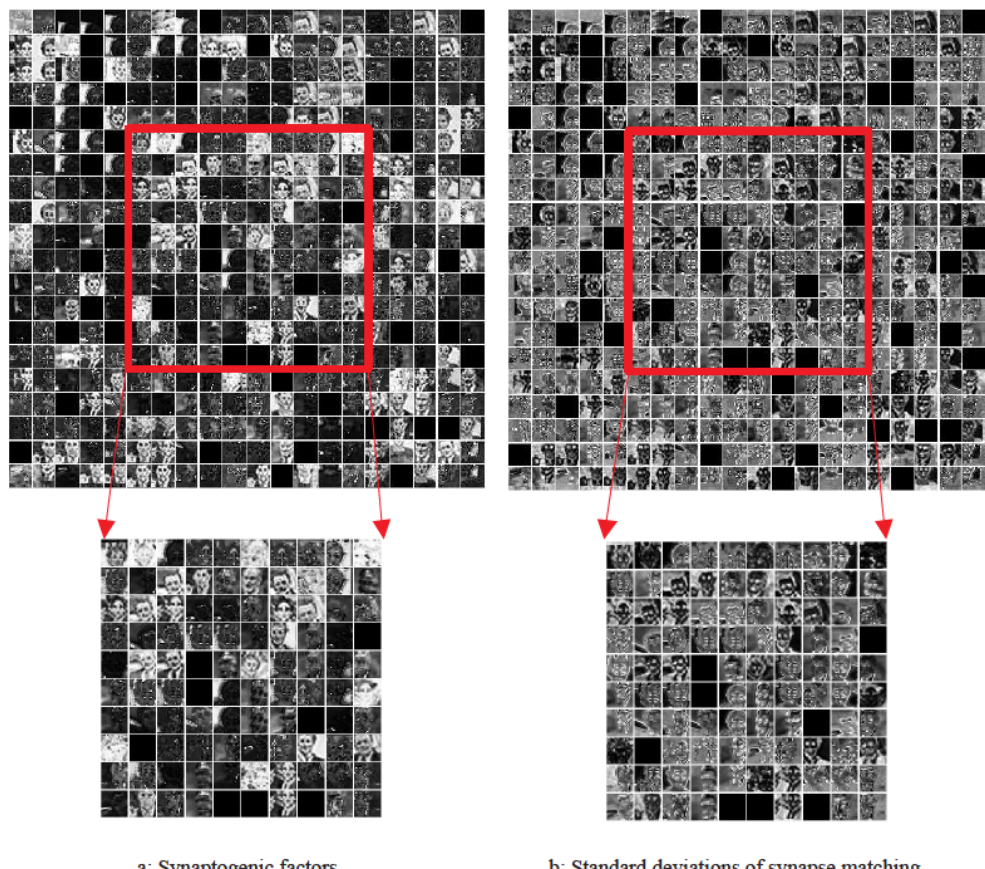
Figure 6: Visualizations of the Synaptogenic Factors and the Standard